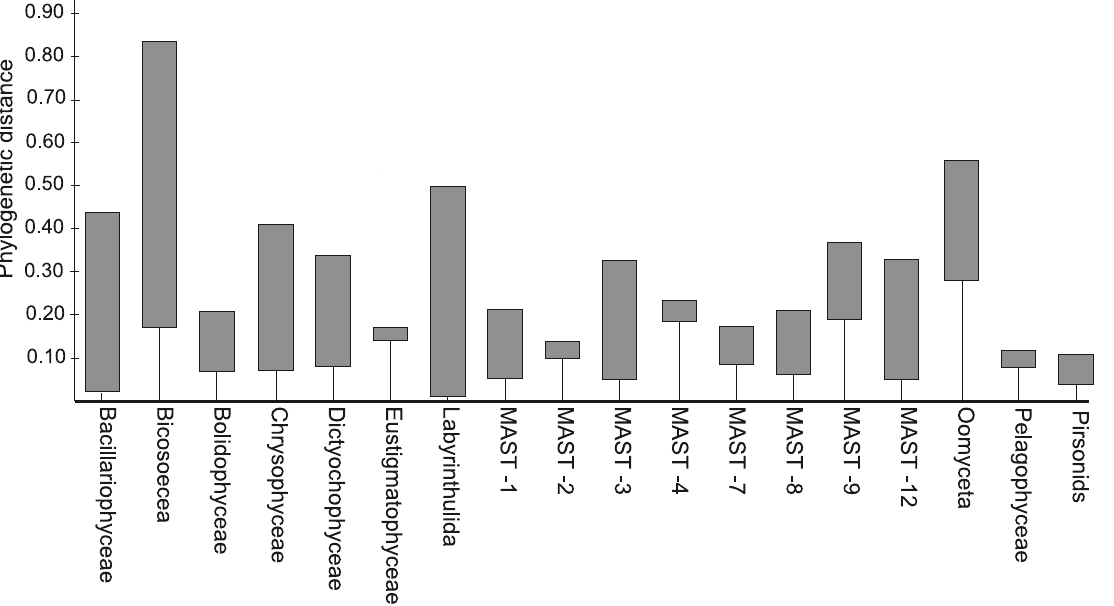
Figure 6. Intragroup phylogenetic distance and trunk length of Stramenopiles groups. A complementary view of phylogenetic structure of Stramenopiles is shown by displaying the trunk length (vertical lines) and the Mean Phylogenetic Distance (vertical boxes) of each group (based on tree in Figure 2B).